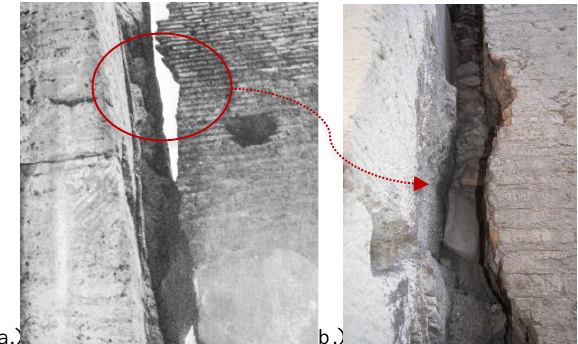
Figure 15. a.) Image taken during the retrofit interventions of 1978 and 1979; b.) Photo taken during the 2015-2016 surveys from the same point of view.